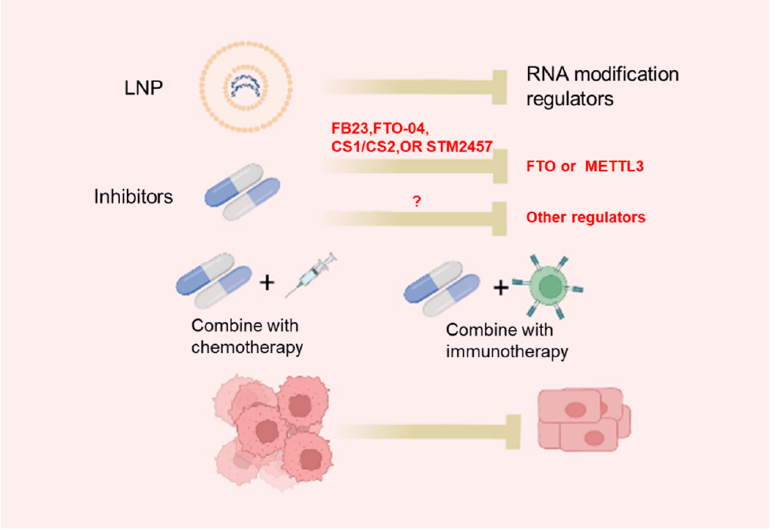
Figure 2. Approaches to target RNA modifications: LNP-siRNA or specific small molecular inhibitors targeting RNA modification regulators.